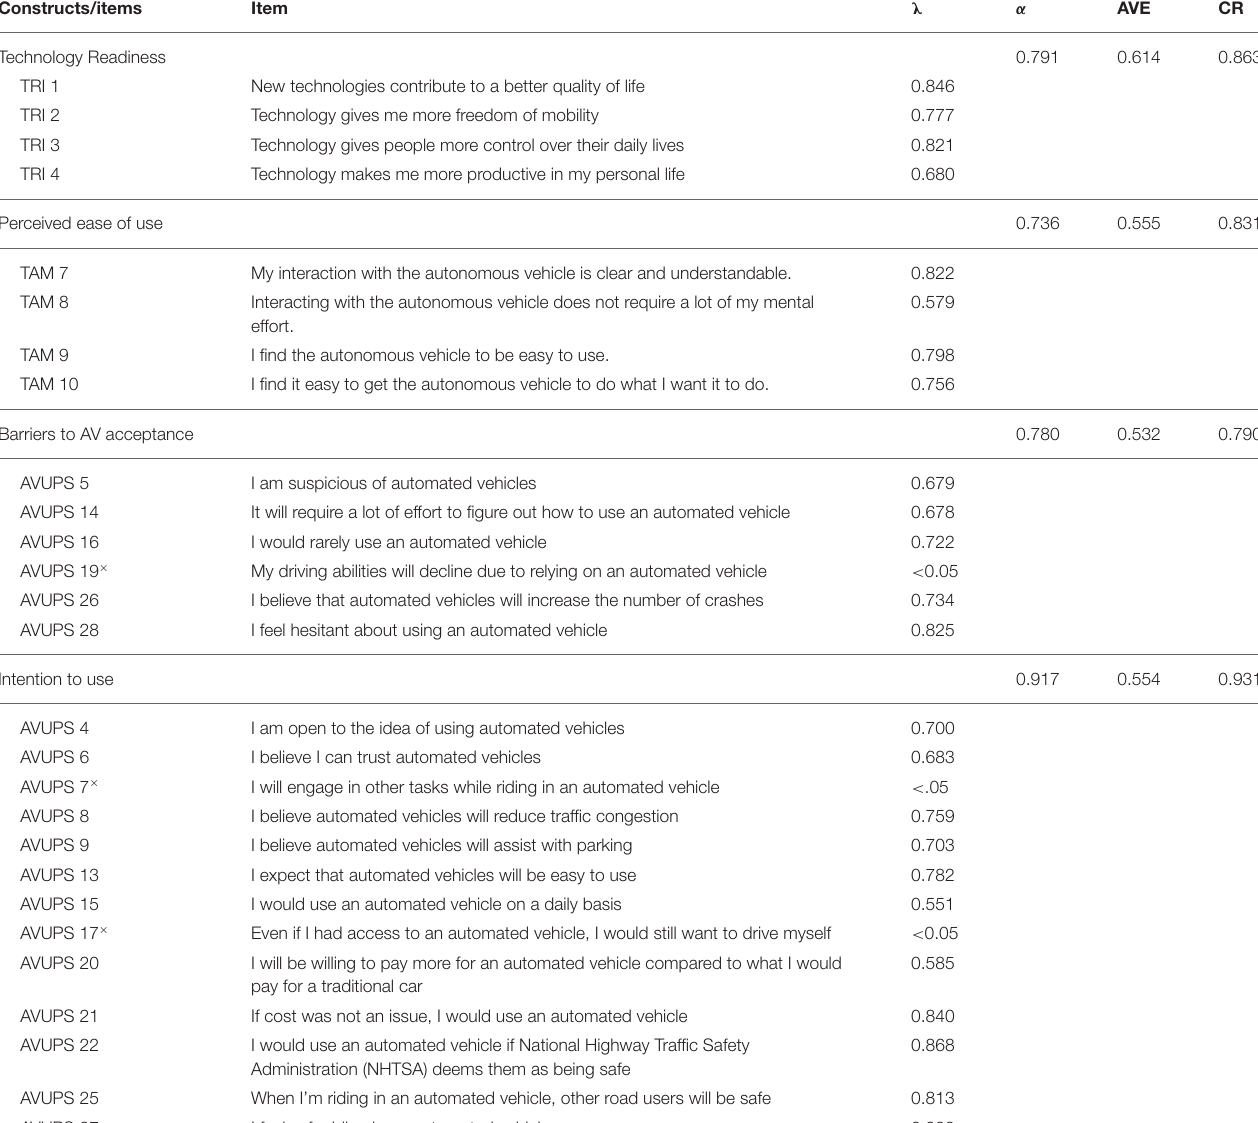
TABLE 1 | Items, item factor loading, internal consistency ( α ), average variance extracted (AVE), and construct reliability (CR) for the PLS-SEM ( N = 104).